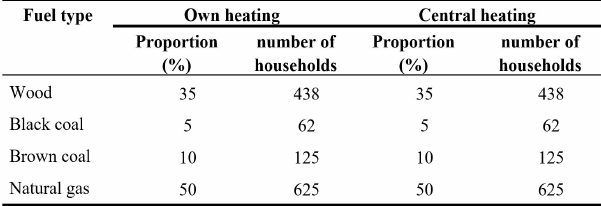
Table 6. Distribution of fuel types between inhabitants of the mathematical